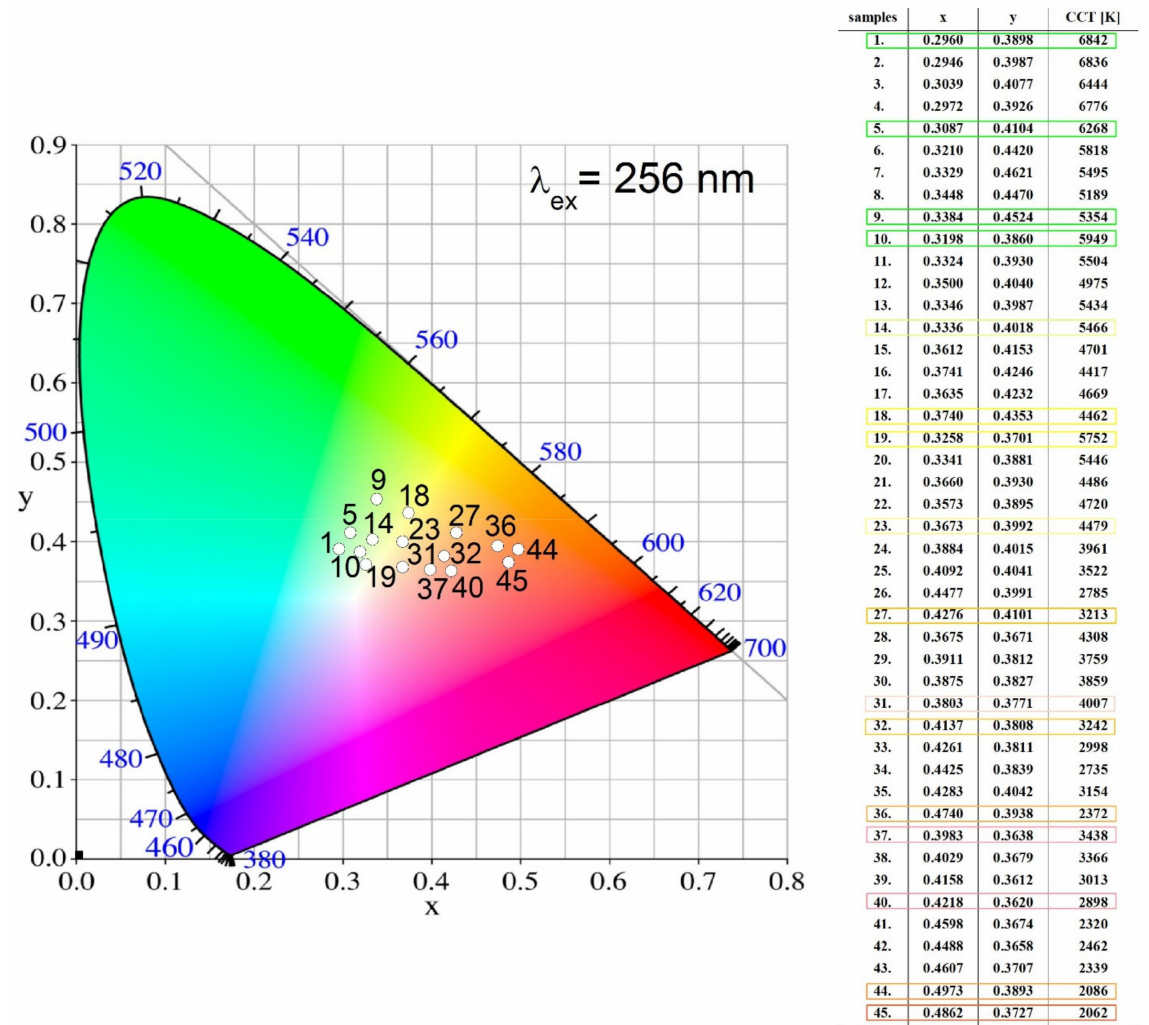
Figure 7. CIE chromaticity diagram, chromaticity coordinates, and correlated color temperature (CCT) of all phos- phors of the CaMo y W 1 − y O 4 :Eu 3+ x /Tb 3+ 1 − x series excited at 256 nm: series 1–9: Eu 3+ 0.001 /Tb 3+ 0.009 Mo (0.1–0.9) W (0.9–0.1) , series 10–18: Eu 3+ 0.003 /Tb 3+ 0.007 Mo (0.1–0.9) W (0.9–0.1) , series 19–27: Eu 3+ 0.005 /Tb 3+ 0.005 Mo (0.1–0.9) W (0.9–0.1) , series 28–36: Eu 3+ 0.007 /Tb 3+ 0.003 Mo (0.1–0.9) W (0.9–0.1) , series 37–45: Eu 3+ 0.009 /Tb 3+ 0.001 Mo (0.1–0.9) W (0.9–0.1)